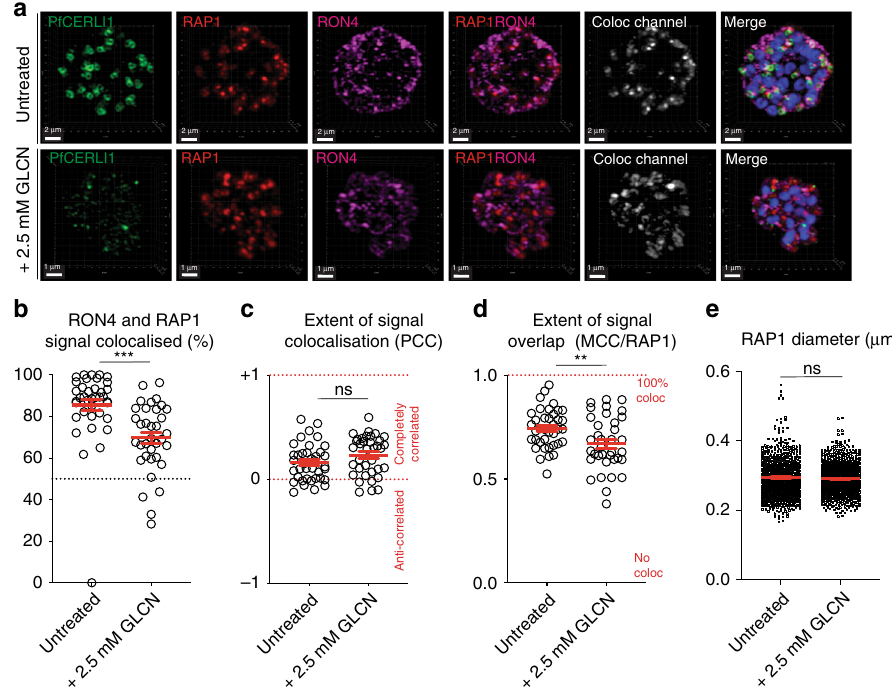
Fig. 5 PfCERLI1 HAGlmS knockdown alters rhoptry antigen distribution. a 3D reconstructions of super-resolution (Airyscan) micrographs for PfCERLI1 HAGlmS schizont cultures that were either left untreated or treated with glucosamine ( + 2.5 mM GLCN) before being stained with DAPI (nucleus), anti-HA (PfCERLI1), anti-RAP1 (rhoptry bulb) and anti-RON4 (rhoptry neck) antibodies. According to the image analysis pipeline detailed in Supplementary Fig. 7, the ( b ) % of RON4 that colocalised with RAP1, ( c ) Pearson ’ s correlation coef fi cient (PCC) of the amount of RON4 colocalising with the RAP1 signal, and ( d ) thresholded Mander ’ s correlation coef fi cient (MCC) of RON4 overlap with RAP1 signal was compared between PfCERLI1 HAGlmS knockdown and control parasites. Each data point represents a single schizont image ( n = 5 biological replicates, 38 schizonts imaged for untreated and 36 for + 2.5 mM GLCN schizonts). e Rhoptry bulb (RAP1) diameter was measured between untreated and PfCERLI1 HAGlmS knockdown ( + 2.5 mM GLCN) parasites. Each data point represents a single rhoptry ( n = 5 biological replicates, 1220 rhoptries counted for untreated and 1217 for + 2.5 mM GLCN). (ns = p > 0.05, ** p < 0.01, *** p < 0.001 by one-way unpaired t-test). All error bars =